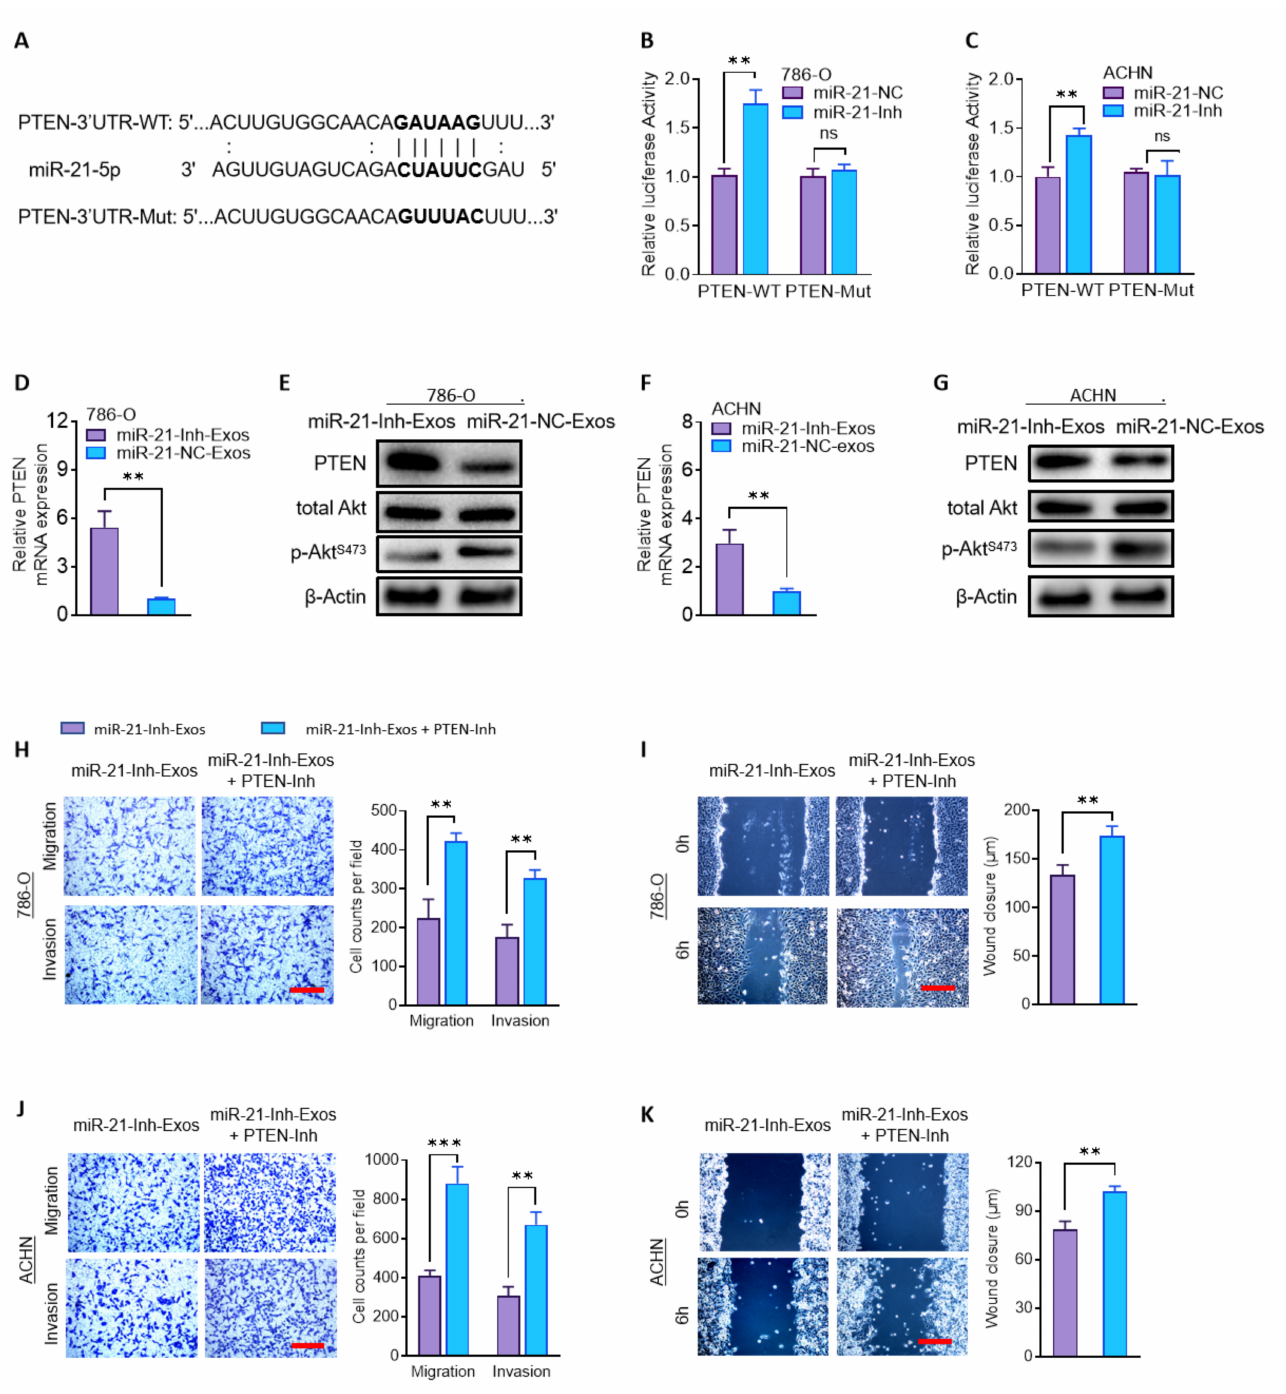
Figure 6. MiR-21-5p in M2-Exos regulates PTEN/AKT signaling to promote RCC metastasis. ( A ) The sequences of the putative target site for miR-21-5p in the PTEN-3 (cid:48) UTR (PTEN-3 (cid:48) UTR-WT) and a mutated version of this target (PTEN-3 (cid:48) UTR-Mut) were shown. ( B , C ) 786-O and ACHN cells were co-transfected psiCHECK2-PTEN-3 (cid:48) UTR-WT or psiCHECK2-PTEN-3 (cid:48) UTR-Mut, with miR-21-Inh or miR-21-NC. The relative luciferase activities in the cells were assayed. ( D – G ) The expression of PTEN mRNA, and protein level of PTEN, total Akt, and p-AktS473 were assessed in 786-O and ACHN cells treated with miR-21-Inh-Exos or miR-21-NC-Exos. ( H – K ) The migration and invasive capabilities of cells treated with miR-21-Inh-Exos or miR-21-Inh-Exos + PTEN inhibitor (PTEN-Inh) were analyzed by transwell and wound-healing assays. Scale bar, 100 µ m. ** p < 0.01, *** p < 0.001, ns: not